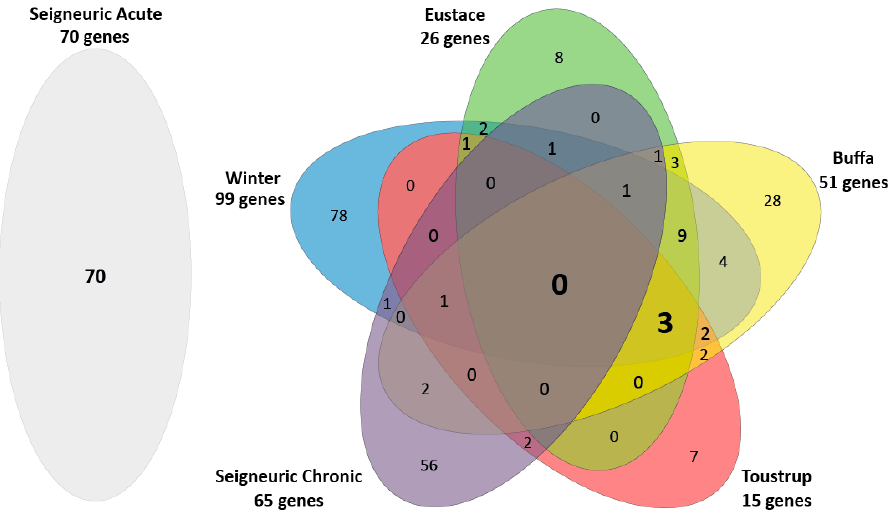
Figure 1. Venn diagram showing the number of overlapping genes in the four clinical hypoxia profiles and the Seigneuric acute and chronic in vitro